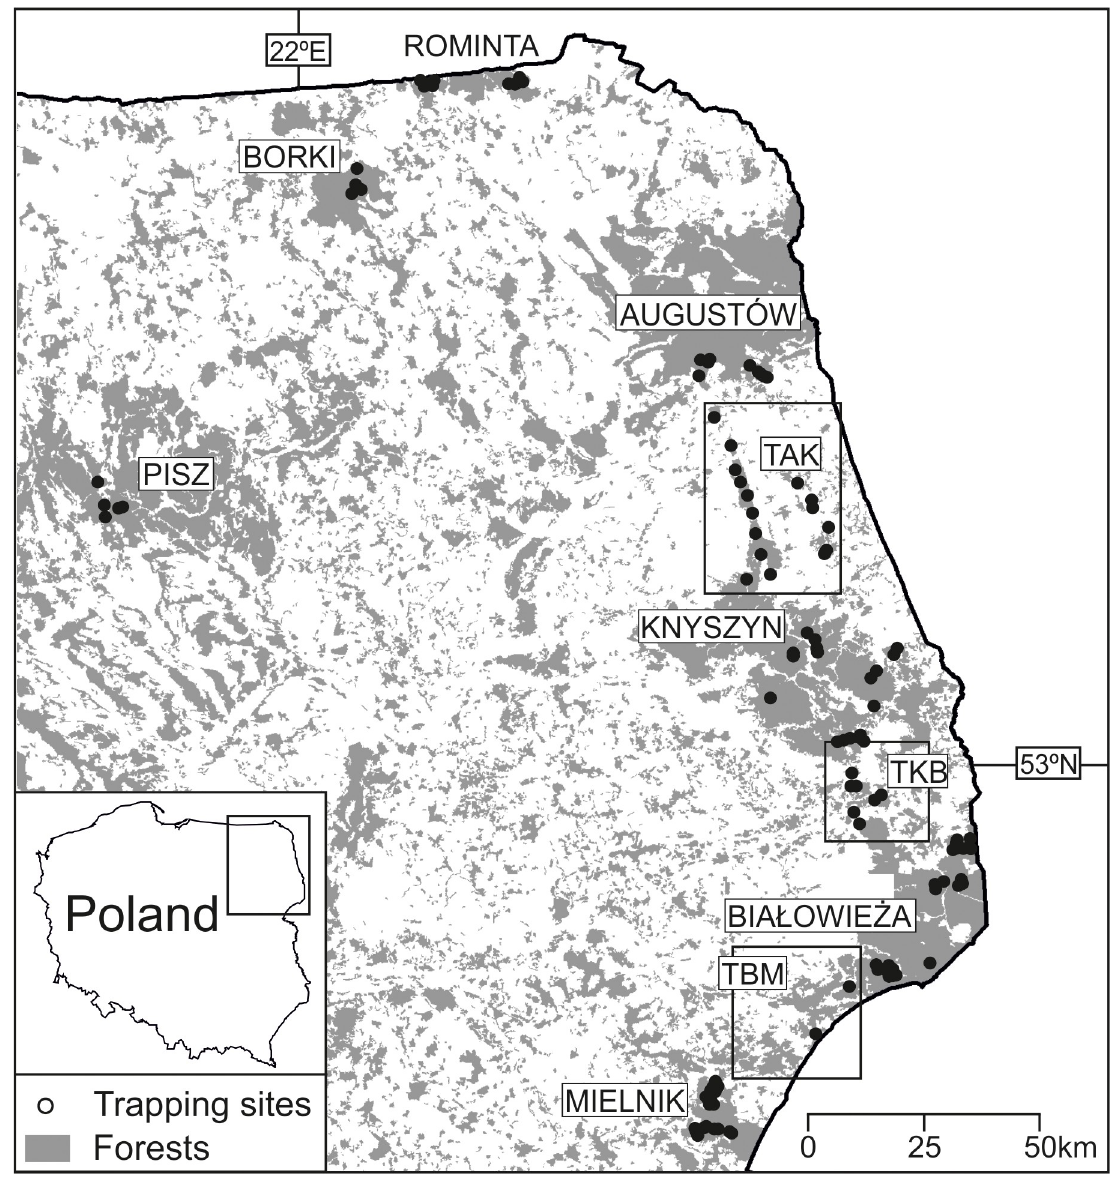
Fig 1. The study area and trapping sites for the yellow-necked mouse Apodemus flavicollis mtDNA analyses in NE Poland. Augusto´w (AUG), Białowie ż a (BIAL), Borki (BOR), Knyszyn (KNYSZ), Mielnik (MIEL), Pisz (PIS), and Rominta (ROM) forests as well as three transects (T) among four of them: Augusto´w − Knyszyn (TAK), Knyszyn − Białowie ż a (TKB), and Białowie ż a − Mielnik